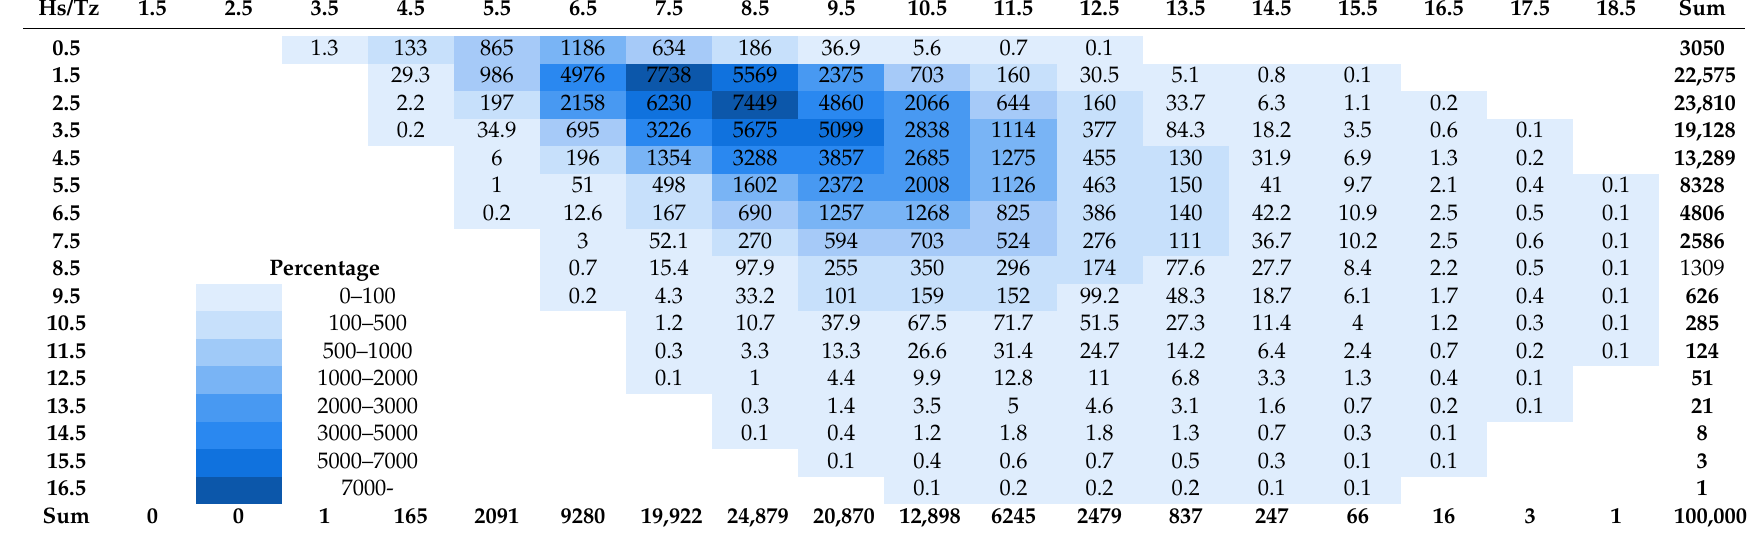
Table 2. Scatter diagram for the North Atlantic sea states.